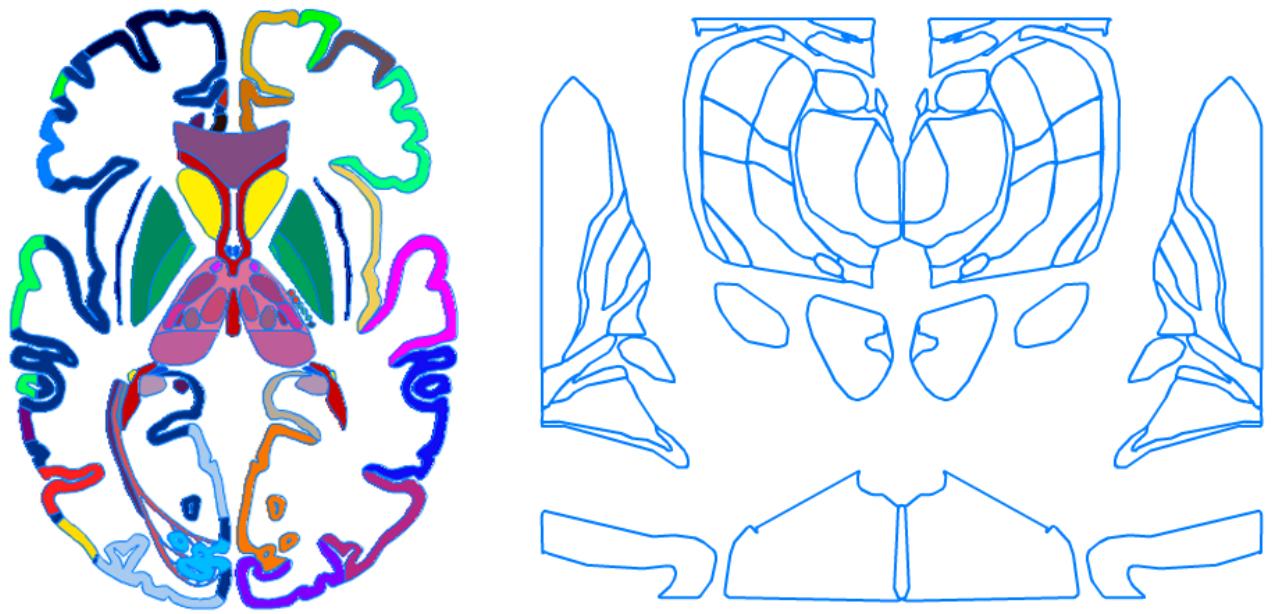
Figure 1. Electronic brain atlases: ( left ) Talairach and Tournoux axial fully color-coded plate 4 mm above the intercommissural plane; ( right ) Schaltenbrand and Wahren coronal microscopic plate in contour representation 4 mm behind the posterior commissure (note that all the contours are closed).